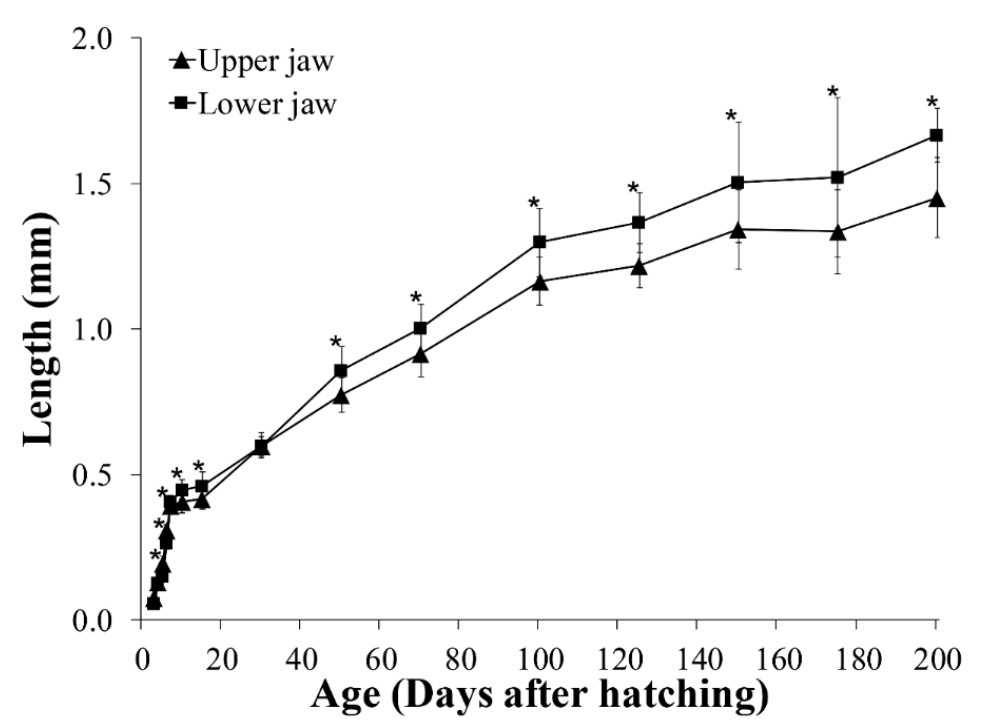
Figure 7. Upper and lower jaw lengths in Anguilla japonica larvae. Values are means ± SD. Asterisks indicate significant differences between upper and lower jaw lengths ( p < 0.05).